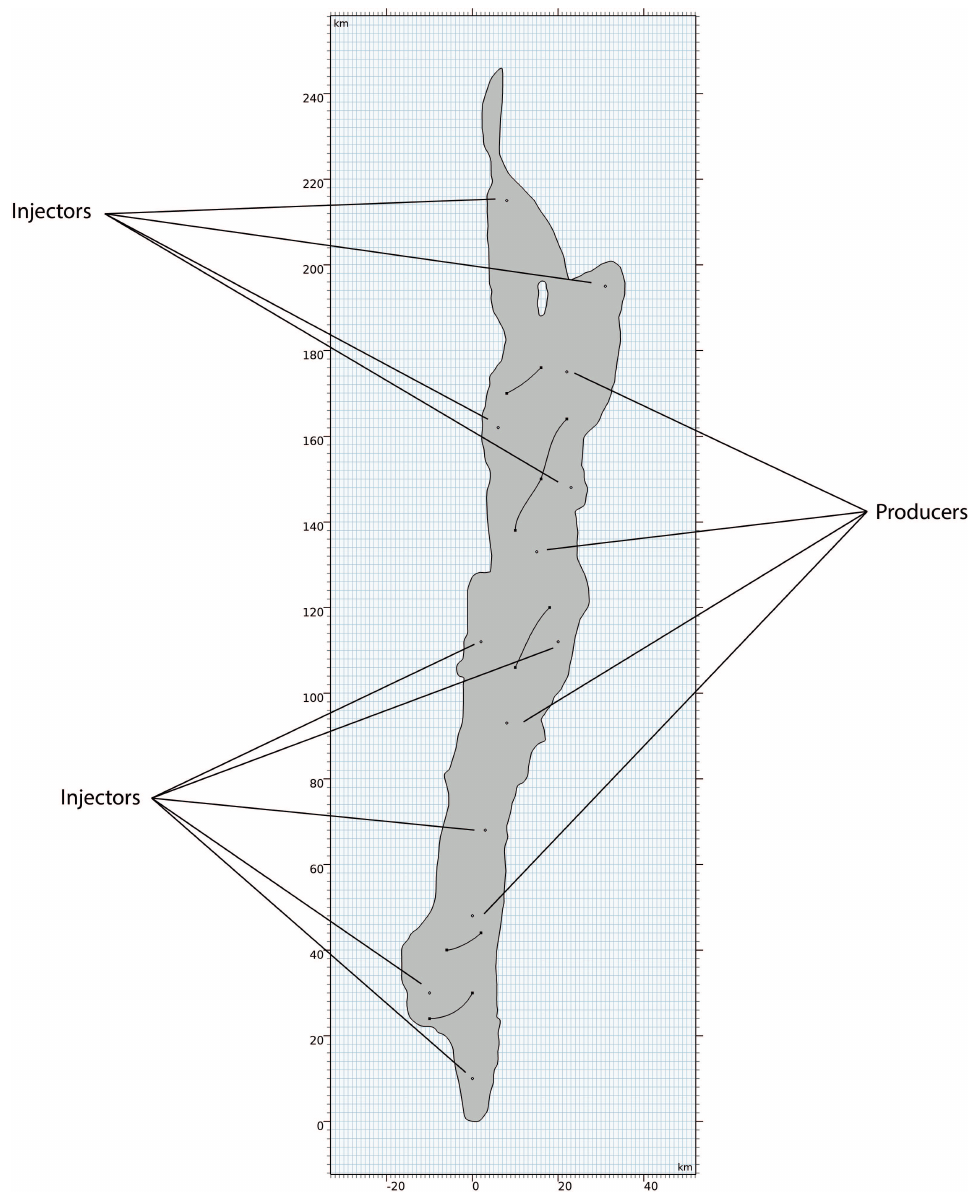
Figure 6. Ghawar numerical model implemented in COMSOL with the studied well